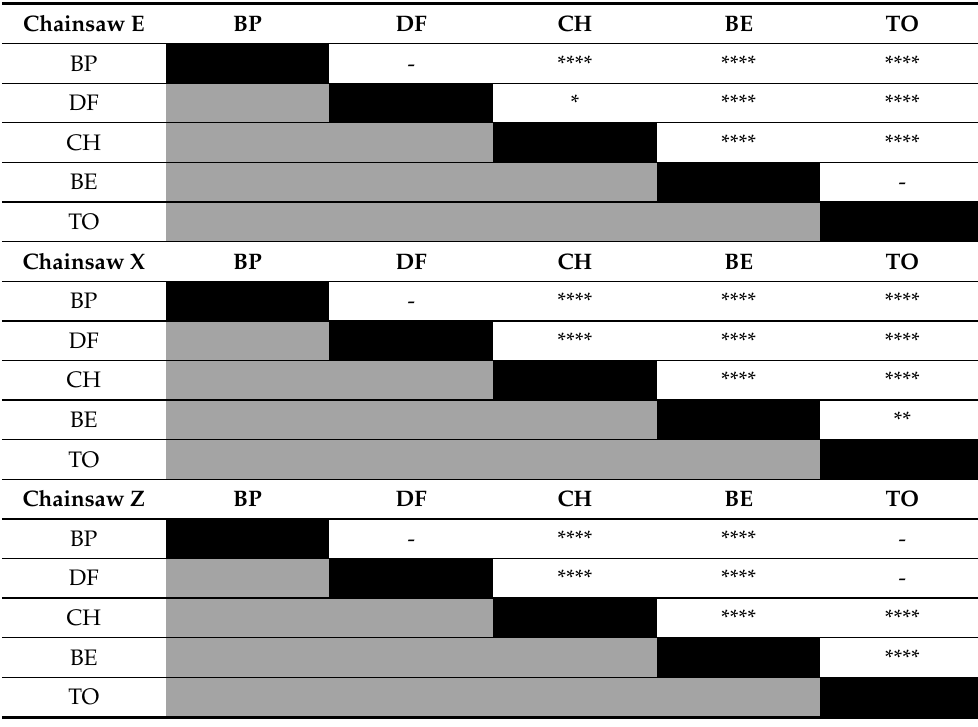
Table 4. Pairwise comparison using the Wilcoxon test for each chainsaw per each wood species.